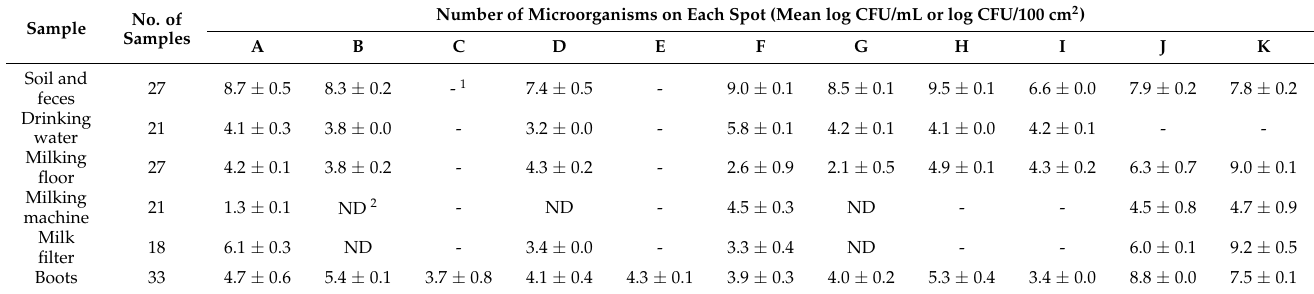
the drain hole, and the niche, the contamination was found to be 0.7~6.4 log CFU/100 cm 2 , room, the space for ripening cheese, the floor of the ripening room, table, and under the ripening table, bacterial counts were 0.5~5.5 log CFU/100 cm 2 , 0.7~4.6 log CFU/100 cm 2 , and 0.7~6.9 log CFU/100 cm 2 , respectively. The count was lower in the ripening room than in the processing room producing cheese. In raw milk and cheese, the bacterial counts